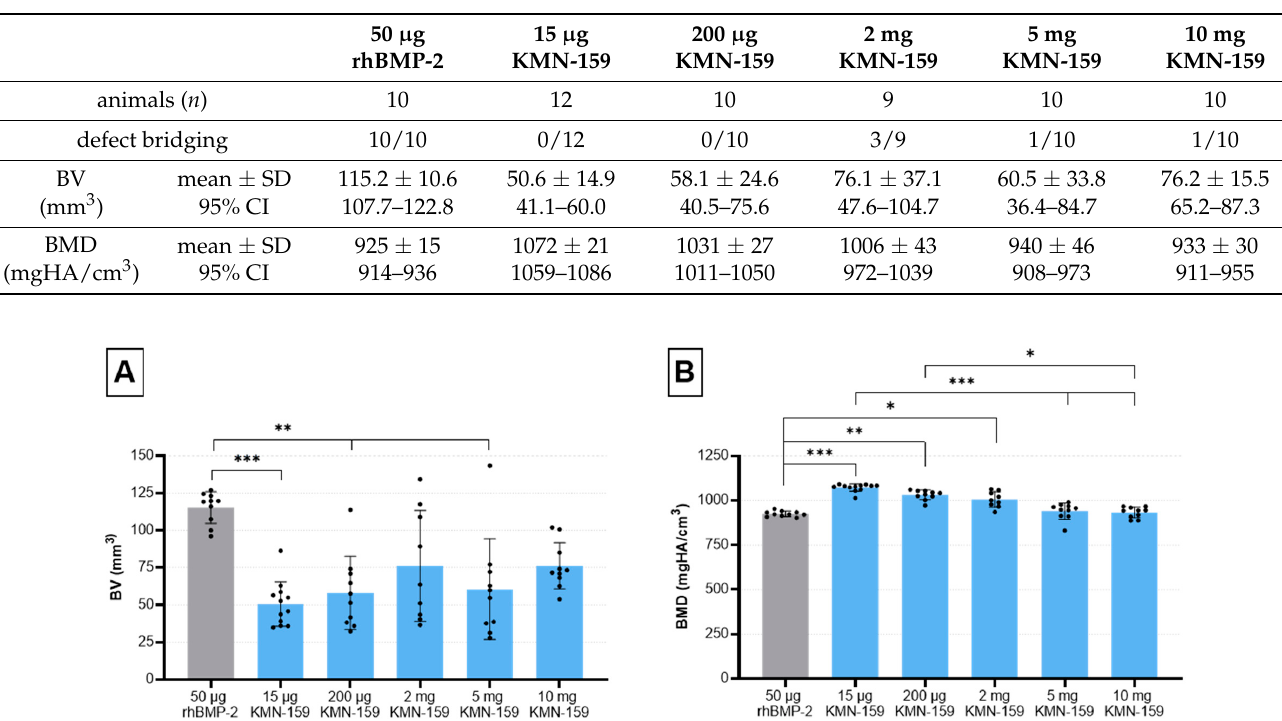
Figure 1. Evaluation of bone defect healing based on µ CT data 12 weeks after surgery. ( A ) bone volume and ( B ) bone mineral density in the defect area (mean ± SD; Kruskal-Wallis following Dunn’s post hoc test: *** p ≤ 0.001, ** p ≤ 0.01, * p ≤ 0.05).